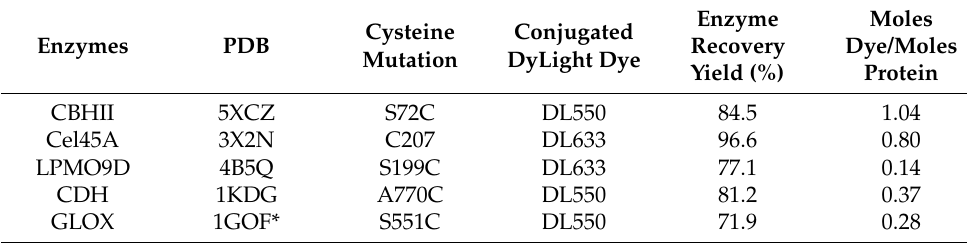
Table 1. Labeling efficiencies of heterologously produced hydrolases and oxidoreductases from P. chrysosporium . A single cysteine residue was introduced within the native protein structures. No crystal structure of GLOX is available. A homology model was built using the SWISS-MODEL with the crystal structure of related galactose oxidase (GAOX) from Fusarium sp. used as a template (pdb: